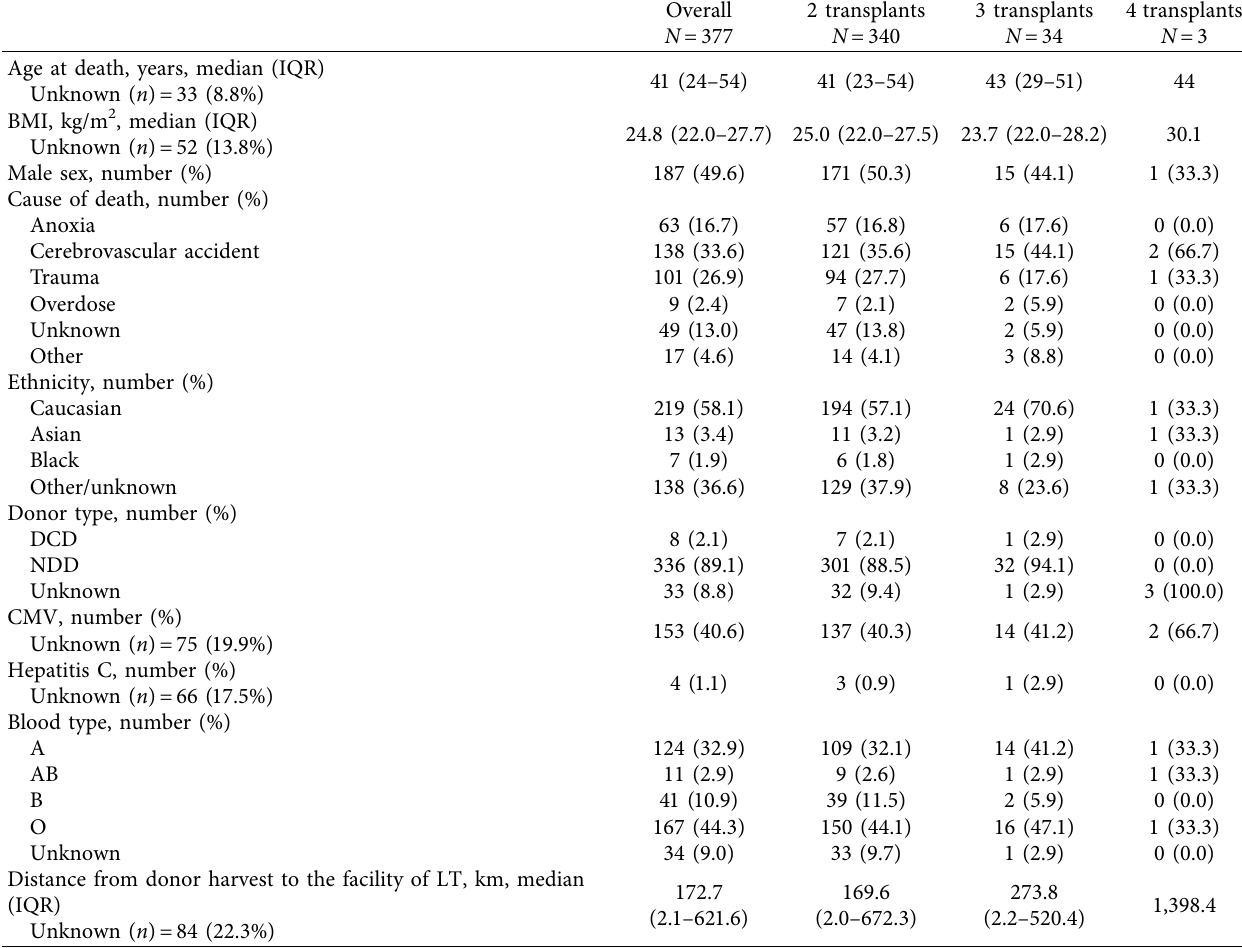
Table 2: Liver retransplant donor characteristics.